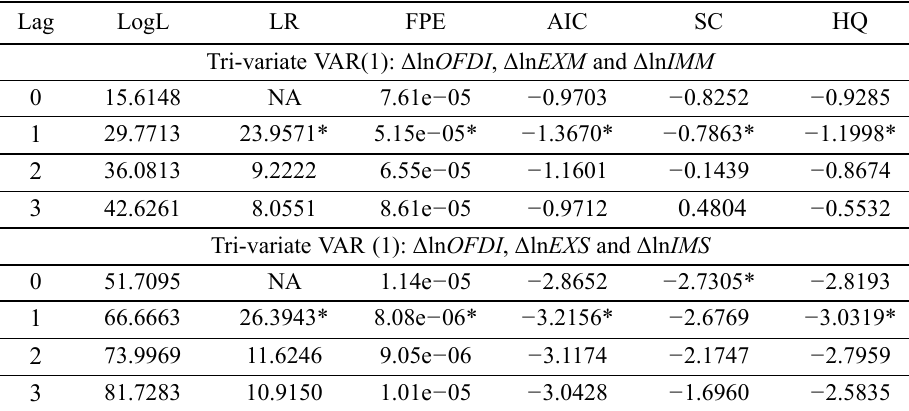
Table 9. Lag length